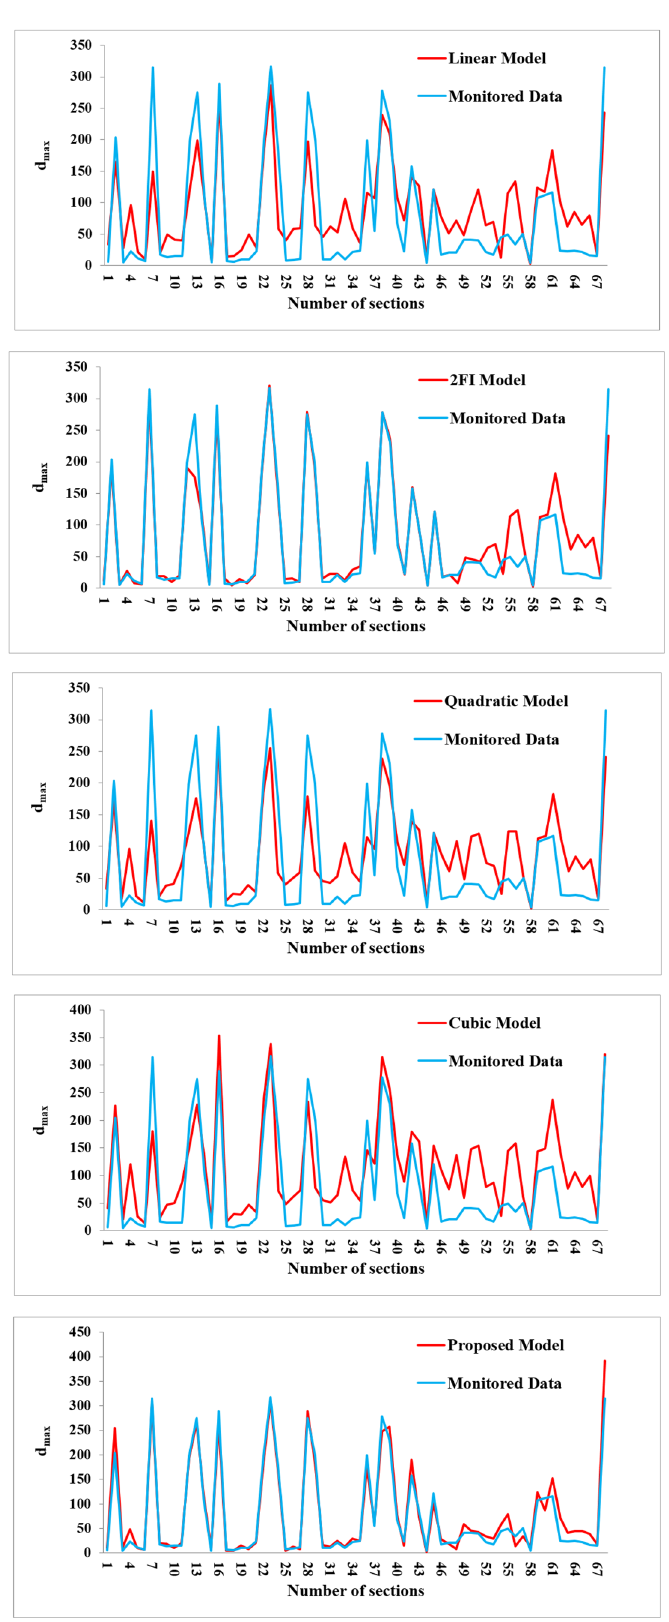
Figure 17. Comparing the results of all models with the real monitored data in 68